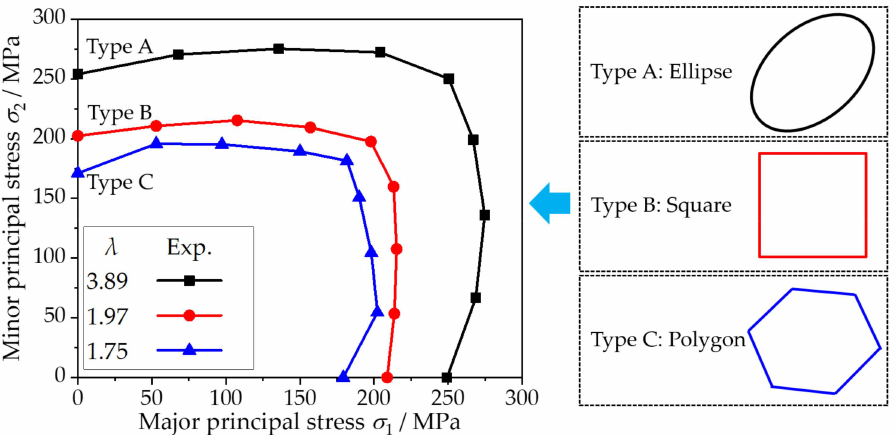
Figure 7. Initial yield loci of metal foils with the thickness of 120 µ m and different grain